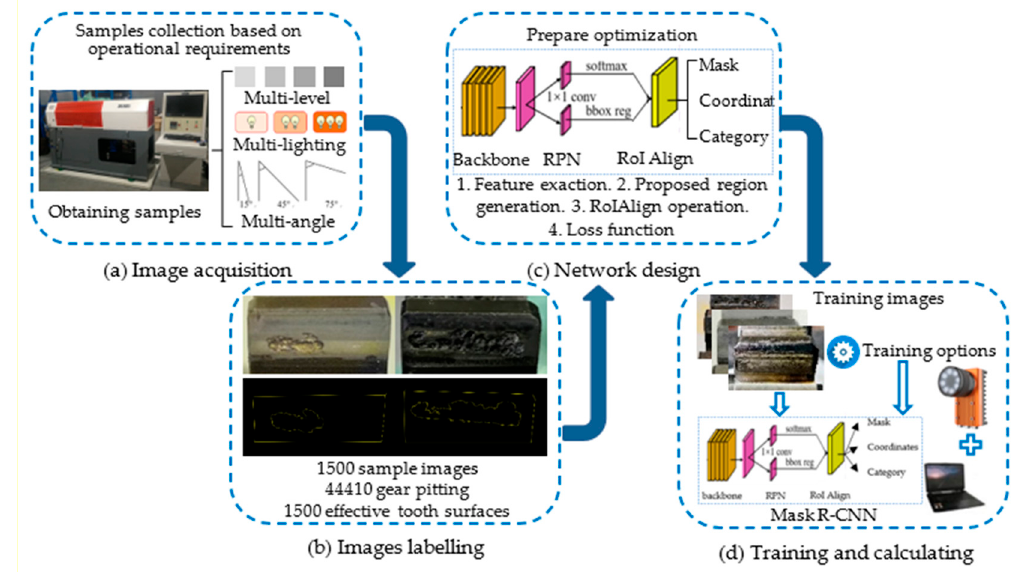
Figure 1. Schematic diagram of the end-to-end implementation process of quantitative detection of gear pitting. Firstly, we obtained image samples under di ff erent experimental conditions, as shown in ( a ). Secondly, we labeled image samples through VGG Image Annotator (VIA), as shown in ( b ). Next, we optimized the super parameters of Mask R-CNN to train the pitting detection network, as shown in ( c ). Finally, we analyzed the experimental results and verified the accuracy of the model in ( d